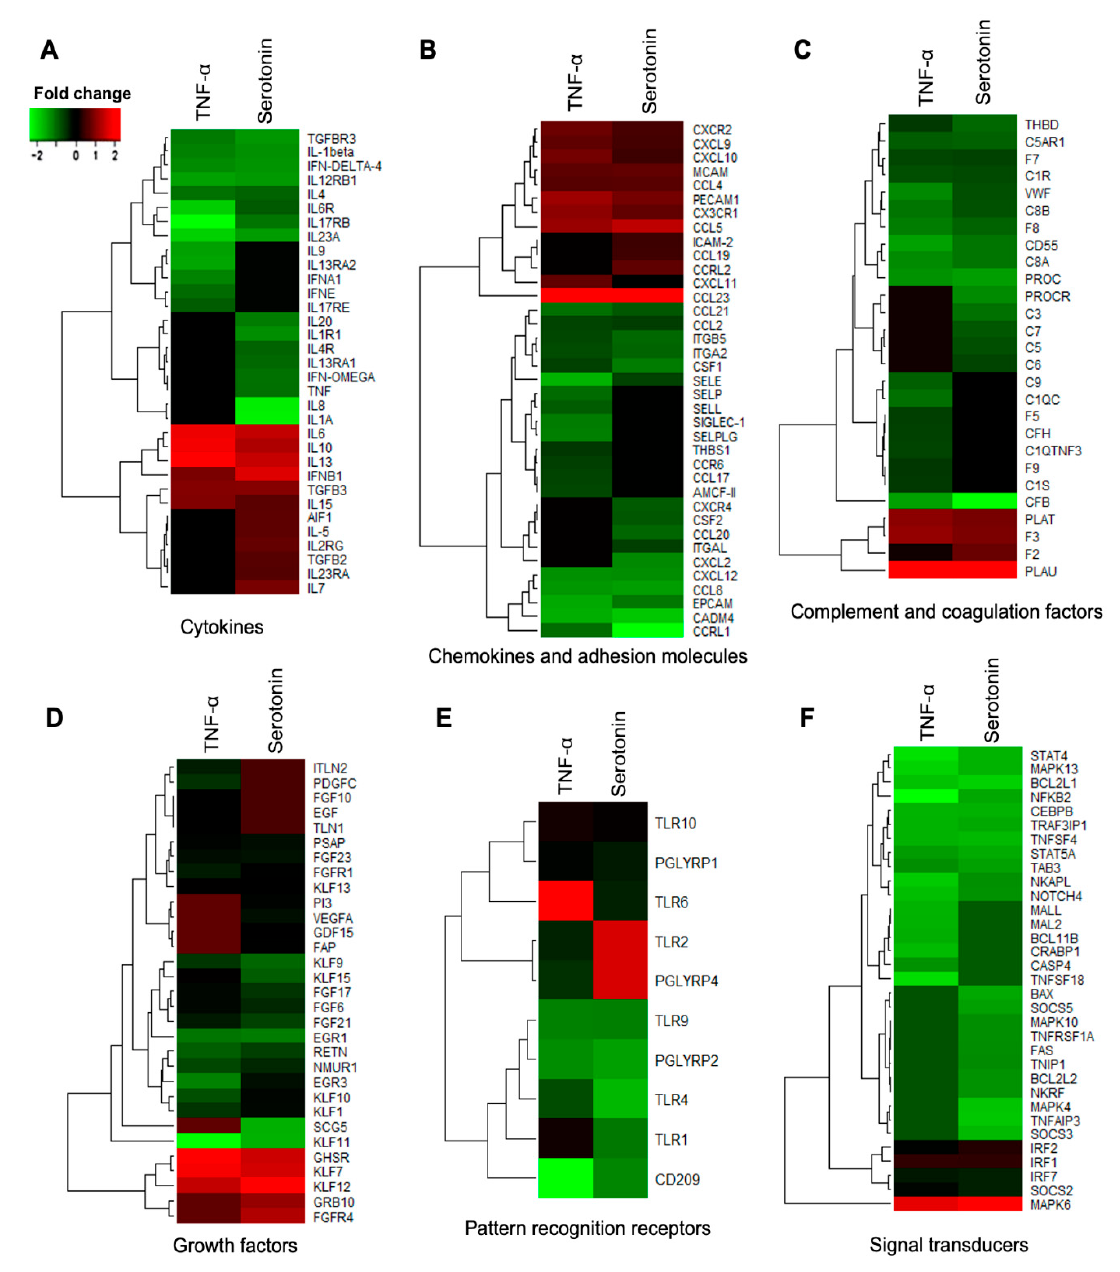
Figure 7. Immune response-related genes di ff erentially expressed in porcine mature adipocytes (pMA) of intramuscular origin after in vitro stimulation with serotonin (100 µ M) and TNF- α (2.5 µ g / mL) both for 12 h. Genes are presented as di ff erent functional groups: A . Cytokines, B . Chemokines, C . Complement factors, D . Growth factors, E . Pattern recognition molecules, and F . Signal transduction molecules. Green color indicates down-regulation and red color for up- regulation.